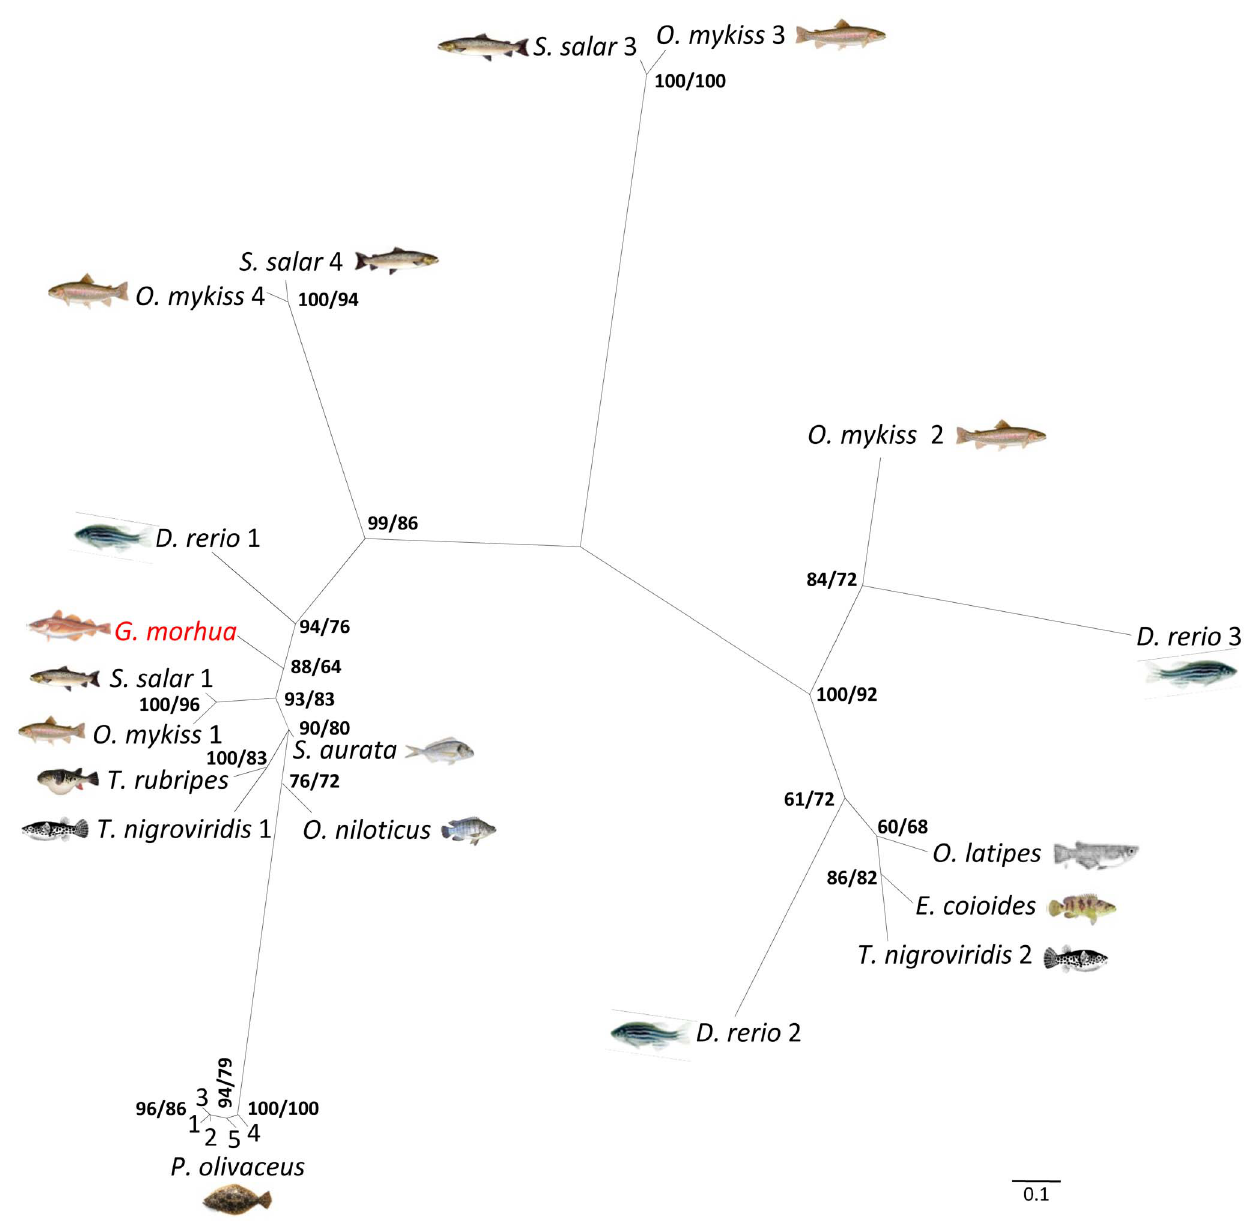
Figure 4. Unrooted radiation tree illustrating the phylogenetic relationship between fish beta-defensins. Cod beta-defensin (highlighted by red) falls into the same clade with a large group of other beta-defensins from different teleost taxa. Bayesian posterior probabilities and maximum likelihood values are indicated as percentages on the tree nodes, respectively.